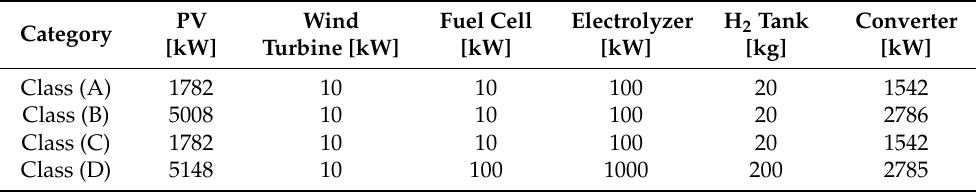
Table 14. Size of each component of the HRES in the future cost scenario.